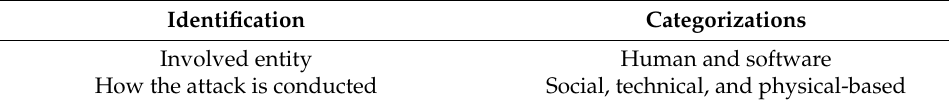
Table 1. Categorizations of social